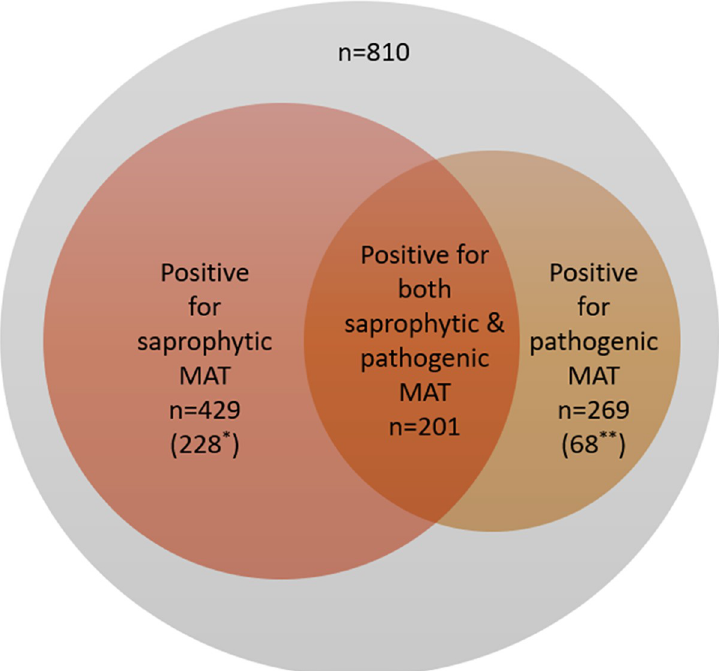
Fig 1. Venn diagram showing MAT positivity based on pathogenic serovar MAT and saprophytic serovar MAT. ( � number positive for saprophytic serovar MAT only, �� number positive for pathogenic serovar MAT only). https://doi.org/10.1371/journal.pntd.0008309.g001 In this study, the 75 th quartile titers were selected as the cutoff for background seropreva- lence for each serovar. These titres are postulated to represent cutoffs for the diagnosis of dis- ease in clinical practice, in the community studied. Based on data presented in Table 3, a cut- off value of 1/80 was determined for serovars Hebdomadis, Icteroheamorrhagiae, Pomona, Ratnapura and Patoc while a value of 1/160 represented cutoffs for serovars Pyrogenes and Cynopteri. Diagnostic cutoff thresholds were recorded at 1/40 for all other serovars (Fig 2). When the proposed new cut-offs are applied to the cohort, the prevalence of the different sero- vars changes considerably, with Bankinang and Australis becoming the most prevalent